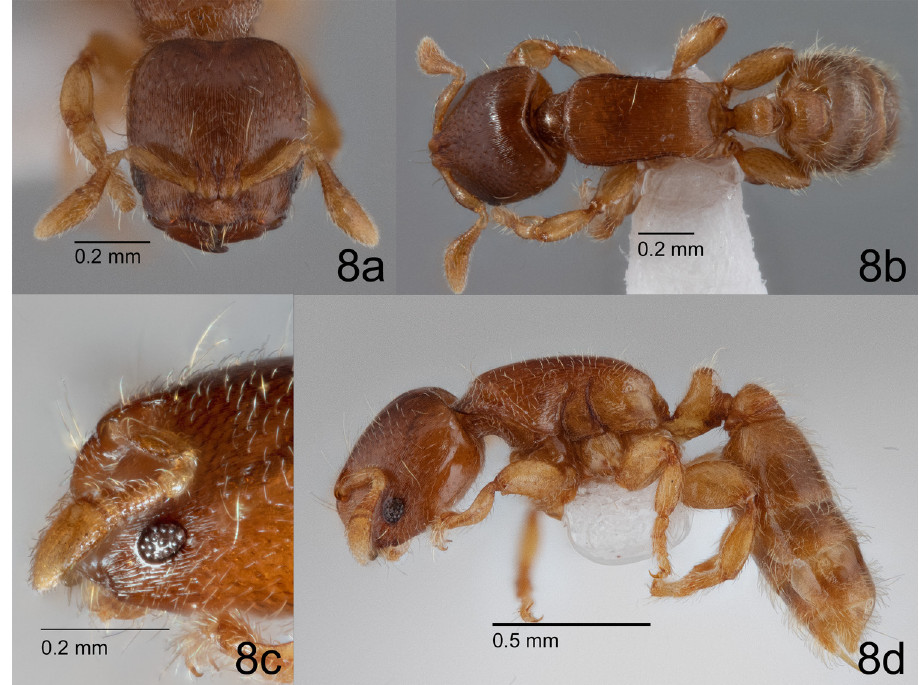
Fig. 8. Rhopalomastix johorensis Wheeler, 1929, non-type, worker, Bangkok, Thailand (ZRC_ ENT00007874.1). a . Head in full-face view. b . Body in dorsal view. c . Closeup of clypeus in profile. d . Body in lateral